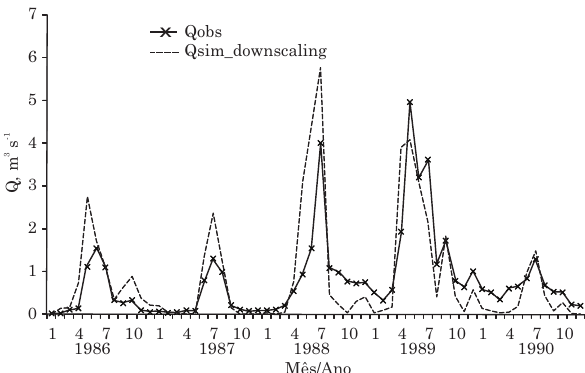
Figura 4. Hidrogramas observados (Qobs) e simulados para o posto Fazenda Pão de Açúcar, com parâmetros calibrados (Qsim_ downscaling ) na Fazenda Cajueiro (1986 a 1990).